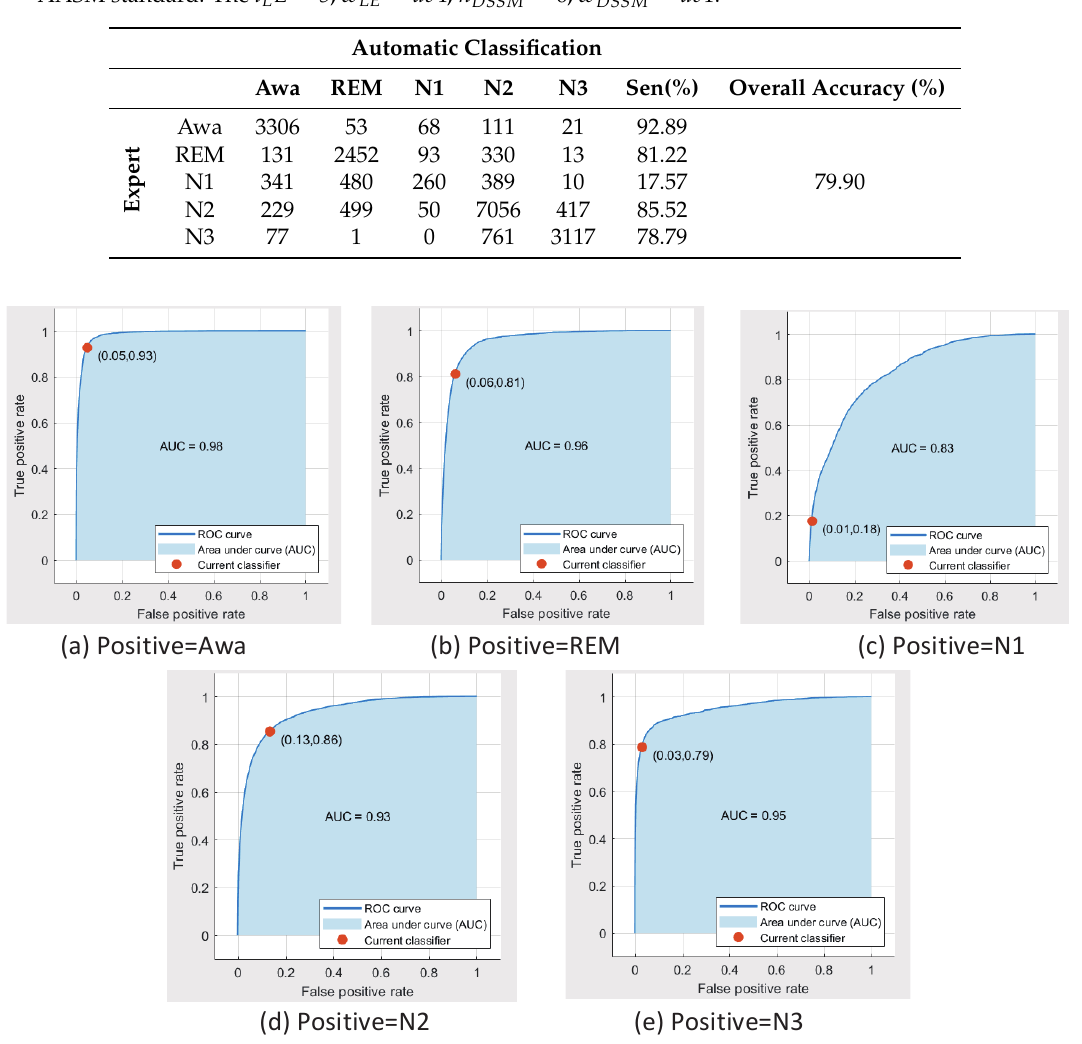
Table 25. The confusion matrix of five classes sleep state classification on DRMS database under the